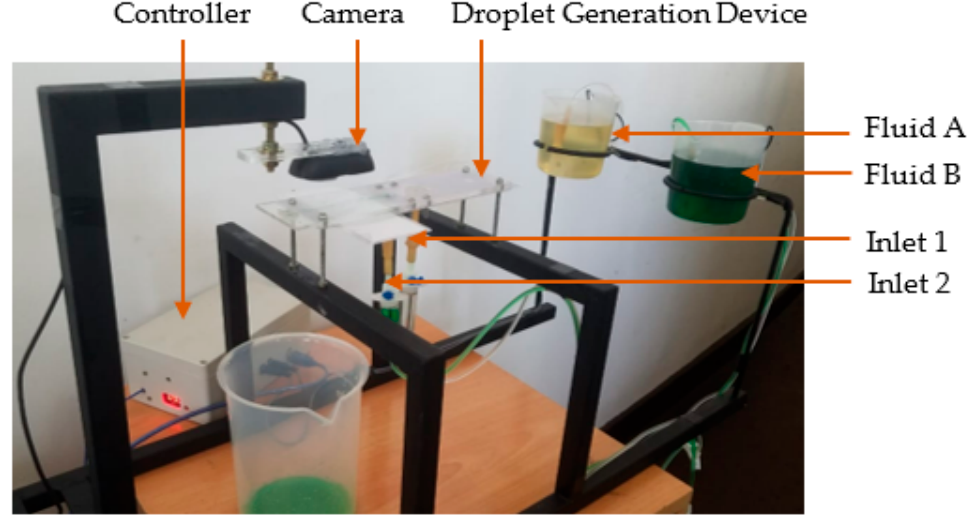
Figure 6. Experimental setup for vision-based droplet generation system.